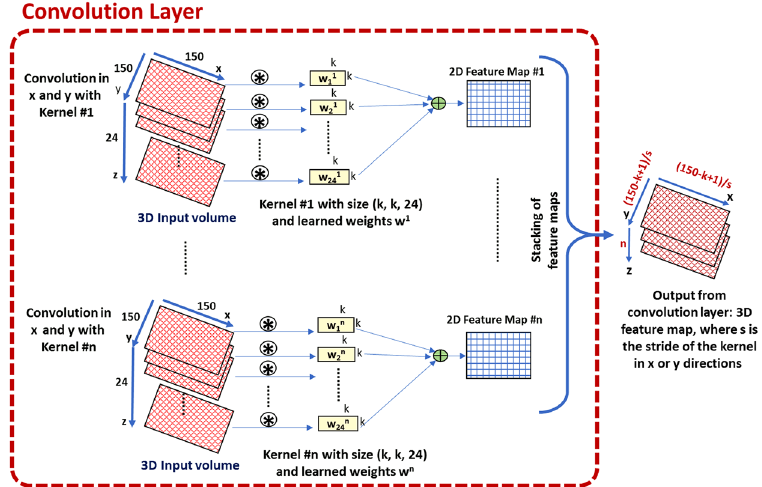
Figure 4. Illustration of the processing of a single volume using CNN. To clarify how a single convolution layer of the CNN processes a 3D input volume of size 150 × 150 × 24 voxels, each 3D volume has 24 images and a 2D convolution is applied to each image using a kernel of size K × K . The output of an individual kernel is then summed to create a 2D feature map. Usually, multiple kernels are used, and the above step is applied again for those kernels, and different feature maps are produced for respective kernels. The final result is a volume of feature